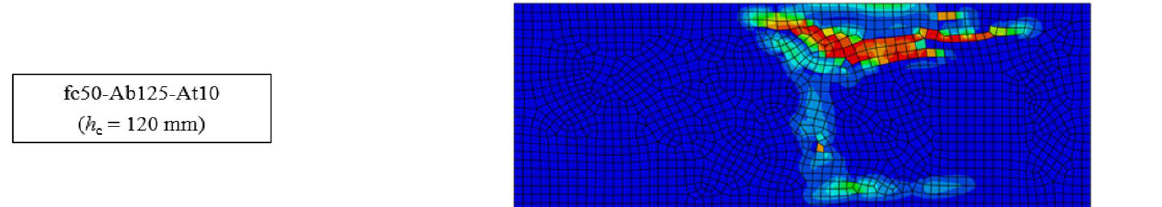
Figure 25. Tensile damage comparison between group D3 and fc50-Ab125-At10 ( h c = 120